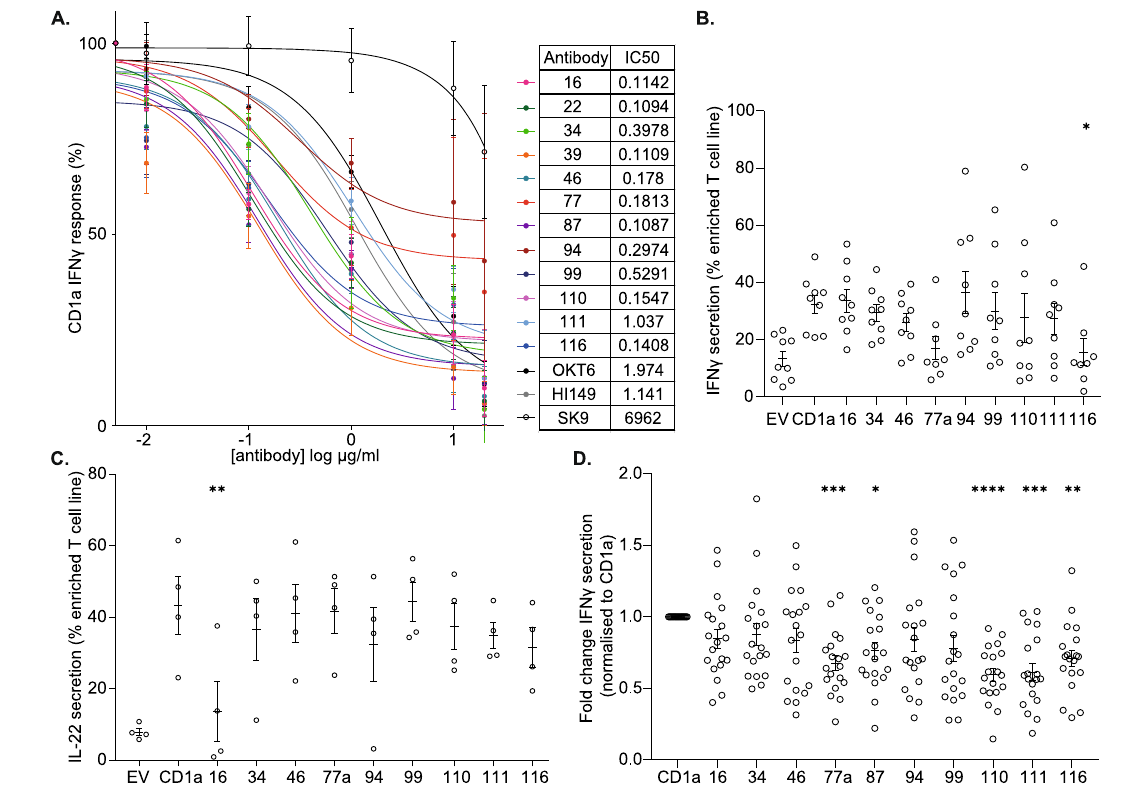
Fig. 2 | Characterization of anti-CD1a antibodies in the inhibition of T-cell responses. A Dose titration curve of polyclonal T-cell IFN γ response with increas- ing concentration of a re fi ned panel of anti-CD1a antibody (0.01 – 10 µ g/ml) as determined by ELISpot ( n =6 donors, mean±SD). And table of half maximal inhi- bitory concentration (IC50) values ( µ g/ml) calculated for the panel of newly gen- erated anti-CD1a antibodies and commercial antibodies (OKT6, HI149 and SK9). n =6 biologically independent blood donors for all groups examined over 4 inde- pendent experiments. B – D Characterization of anti-CD1a antibodies in the inhibi- tion of CD1a-restricted T cells. n represents biologically independent CD1a- restricted T-cell lines. B , C Cytokine secretion response of CD1a-restricted T cells induced by empty-vector (EV)- or CD1a-transfected (CD1a)-K562 presenting